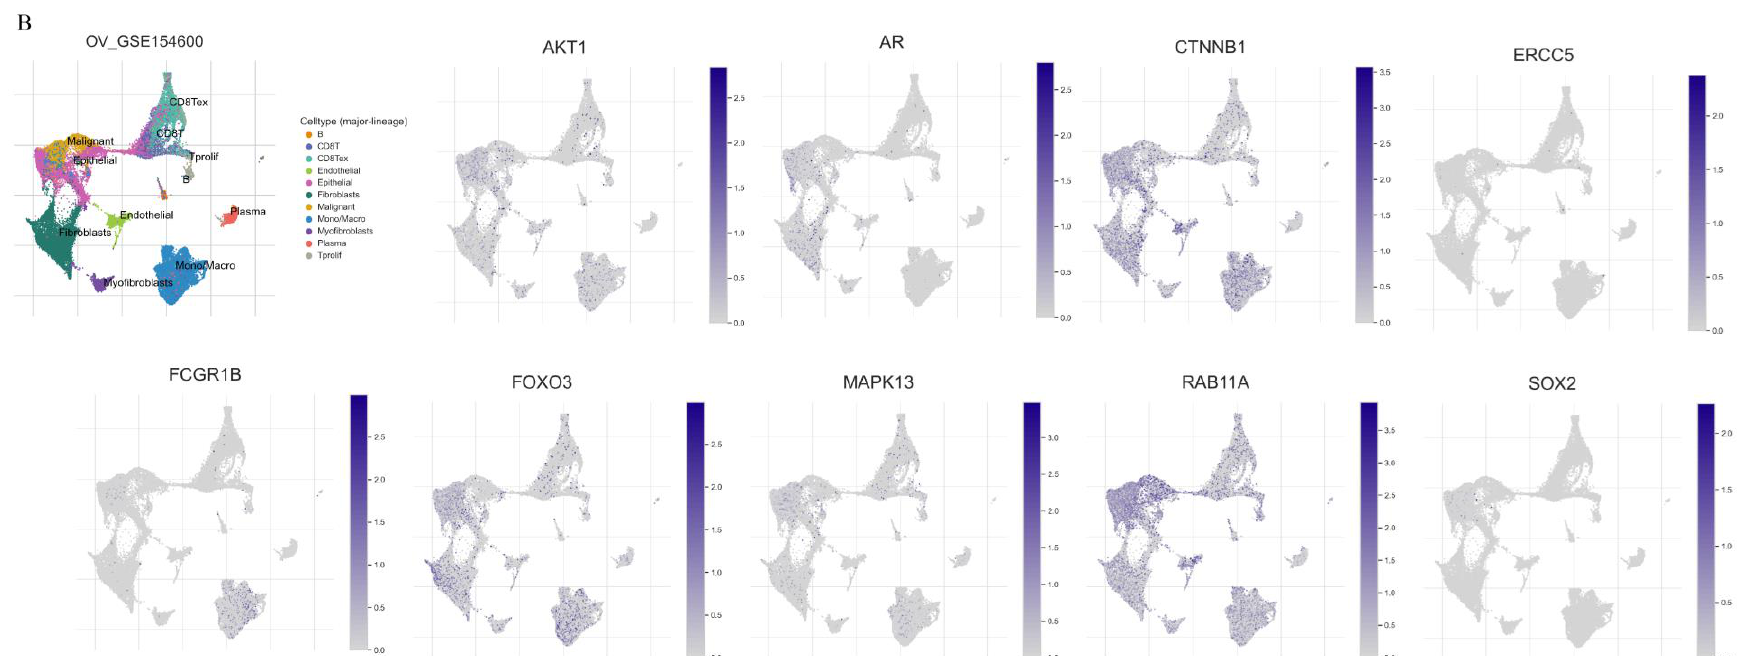
Figure 13. Expression of protein-coding genes in single-cell datasets of ovarian cancer. ( A ) Protein-coding gene expression in EMTAB8107. ( B ) Protein-coding gene expression in GSE154600.